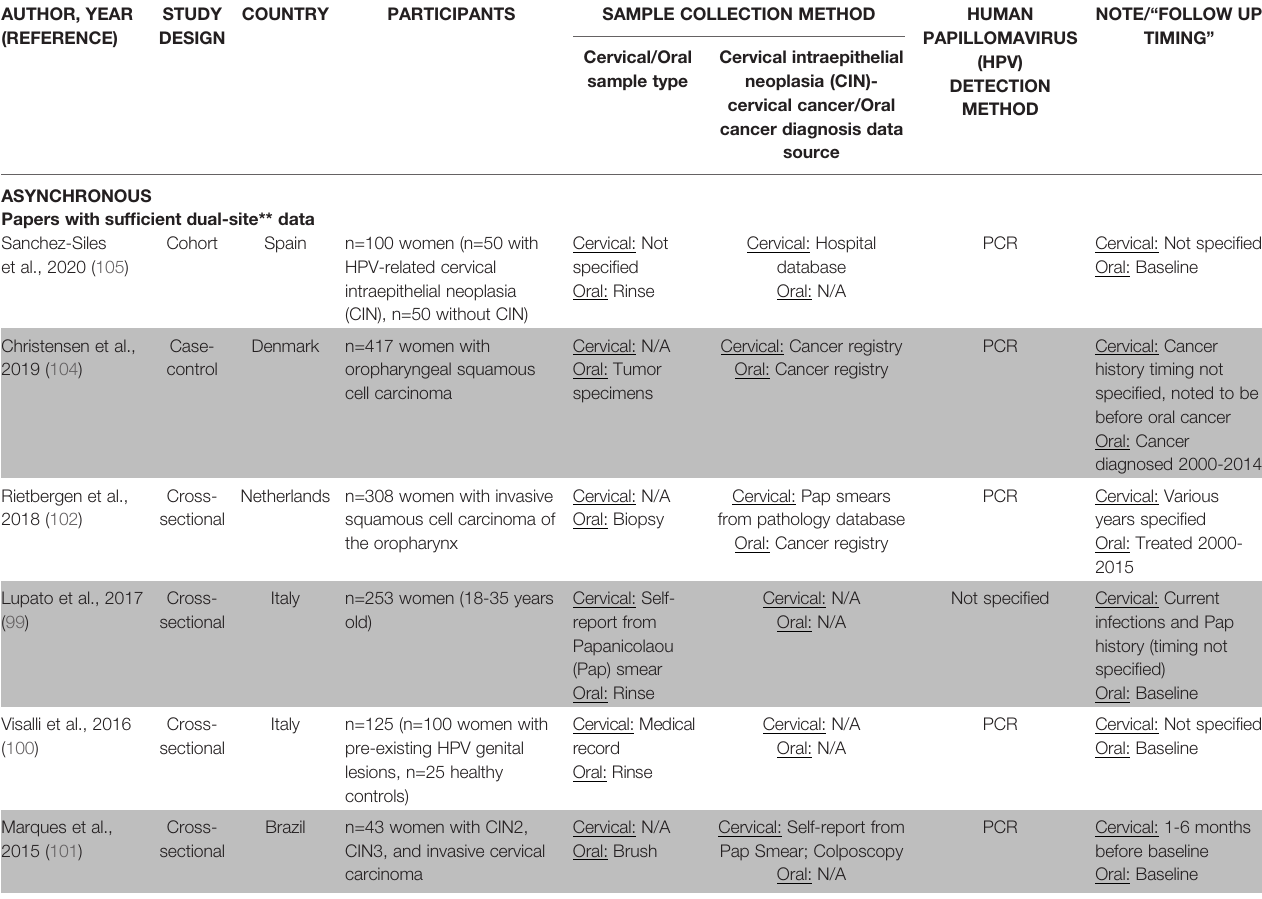
TABLE 2B | Description of methodology used in asynchronous oral-cervical HPV evaluation papers